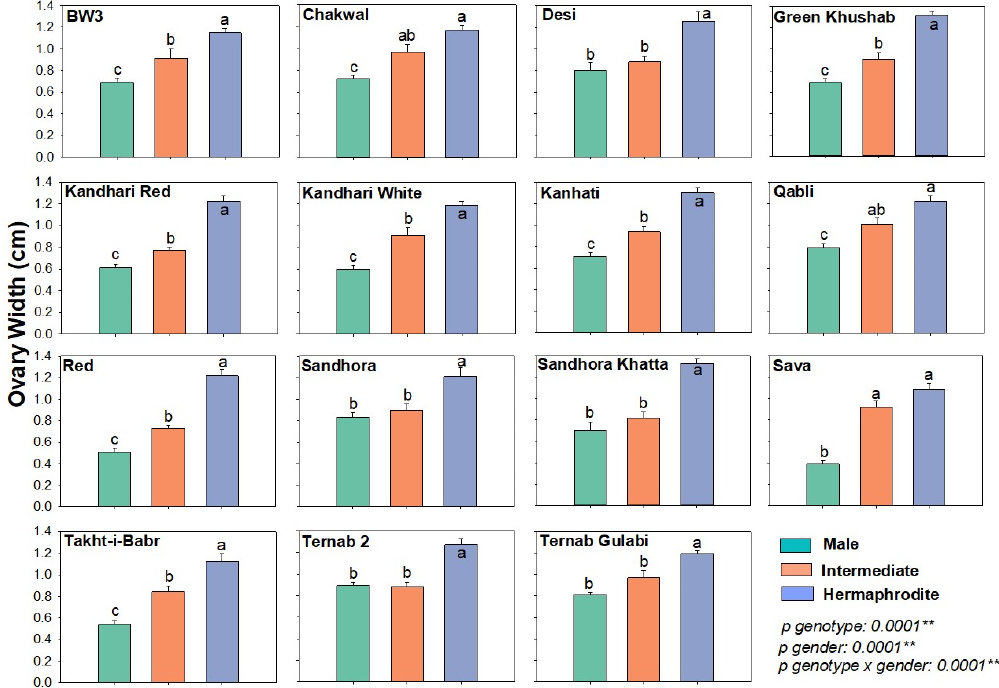
Figure 4. Ovary width (OW) of different flower types in pomegranate genotypes. The width of the ovary was measured in (cm) after dissection of each flower type. After dissecting each flower type, the length was measured in centimeters (cm). The graph represents the mean ± S.E. of five replicates for each flower type. Different letters indicate statistical significance among flower types (Tukey’s HSD p < 0.05), ** indicates significance at p < 0.01.